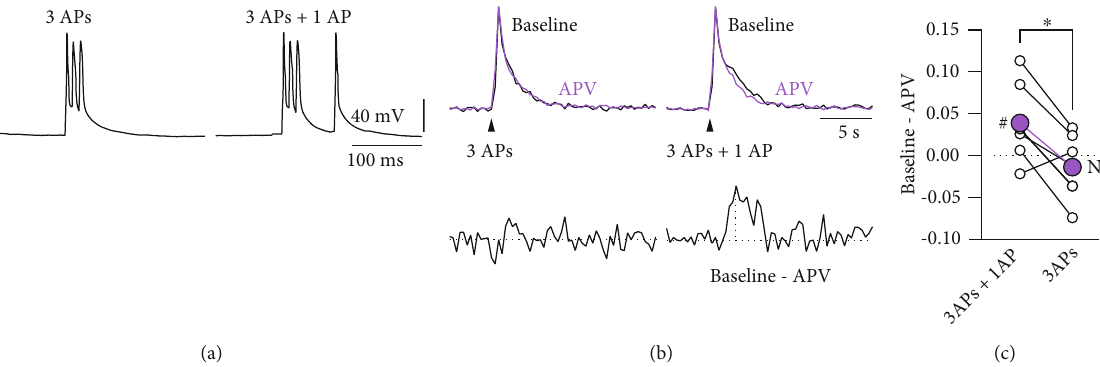
Figure 7: Presynaptic burst patterns evoke an APV-sensitive Ca 2+ transient component. (a) Example of the AP burst patterns that were used to evoke presynaptic Ca 2+ transients in L4 spiny stellate axons. Left, 3 APs at 100Hz. Right, 3 APs at 100 Hz followed 50ms later by a single AP. (b) Axonal Ca 2+ transients evoked by the activity patterns shown in (a) during baseline (black) and after bath application of APV (purple). Lower traces show the di ff erence between the corresponding transients. (c) Comparison of the peak di ff erence between the Ca 2+ transients before and after bath application of APV ( n = 6 ). The 3AP + 1AP activity pattern showed a signi fi cant e ff ect of APV on the evoked Ca 2+ transients, while the Ca 2+ transients evoked by a burst of 3 APs alone were una ff ected by APV. # p < 0 : 05 by paired Student ’ s t -test. ∗ p < 0 : 05 by one-way ANOVA. All data are represented as mean ± SEM .